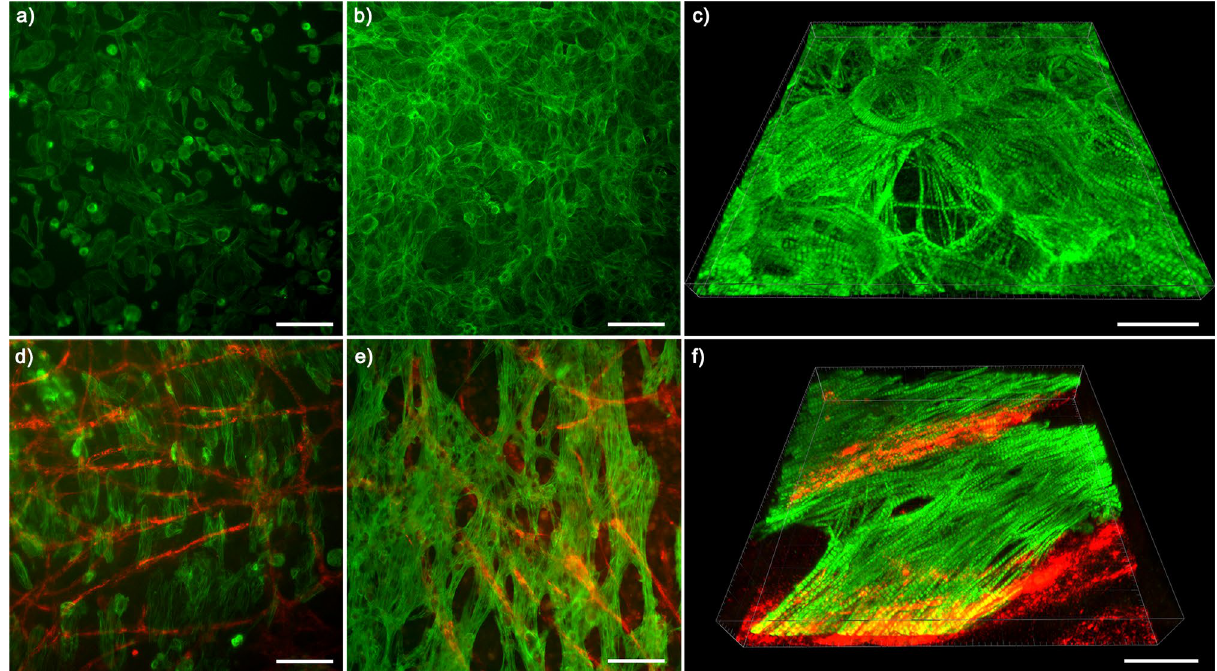
Figure 2. Immunofluorescence staining showed improved structural maturity of cardiomyocytes in cardiac tissue model compared to cardiomyocyte monoculture. ( a ) Immunofluorescence staining of the cardiomyocyte monoculture on day 1 and ( b ) day 7. ( c ) 3D-confocal microscopy image of the cardiomyocyte monoculture on day 8. ( d ) Immunofluorescence staining of the cardiac tissue model on day 1 and ( e ) day 8. ( f ) 3D-confocal microscopy image of the cardiac tissue model on day 8. Green: cardiac troponin T, red: von Willebrandt factor. Scale bar 100 µm ( a , b , d , e ), scale bar 30 µm ( c , f ). The experiment was repeated three